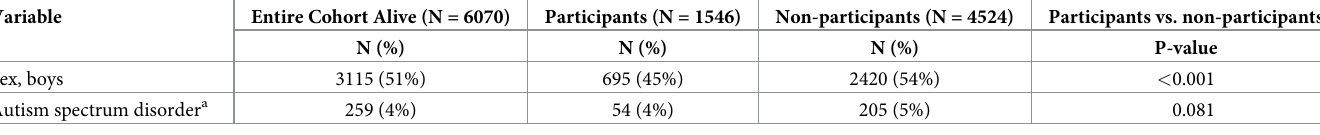
Table 1. Characteristics of the participants in the CCC2000 16-year follow-up compared to non-participants. Variable